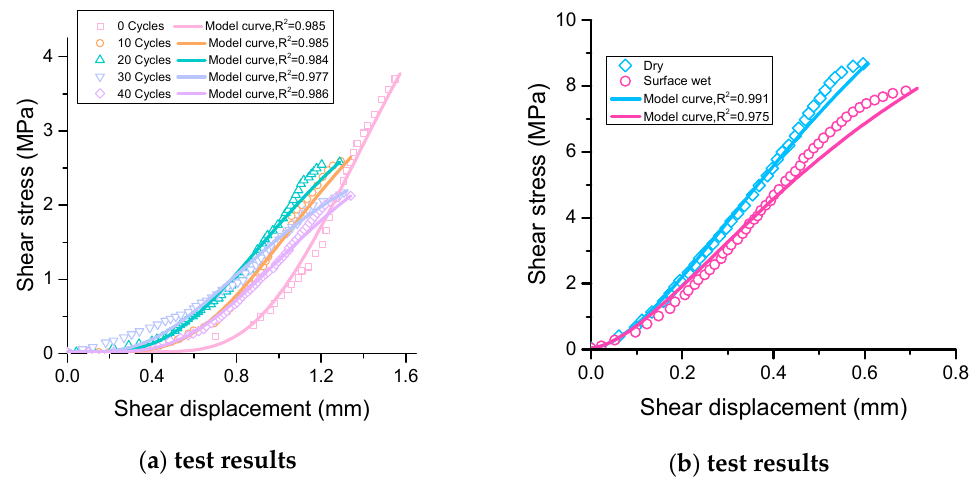
Figure 7. Comparison of test results [73,74] with model curves.The experiment is one of the most fundamental and effective research methods. In Section 3, this paper only focuses on the perfor- mance of the proposed model in describing the shear deformation of rock joints in laboratory ex- periments. Considering that there are many limitations of laboratory experiments, such as difficult field sampling, disturbance to the original state of samples, and defects in laboratory test instru- ments, the results may not be consistent with reality [75]. Therefore, the in situ shear test, which can obtain the mechanical parameters consistent with engineering practice, was employed. Taking the test results [76,77] under in-situ conditions as an example, the perfor- mance of the model in reproducing in situ rock joint behavior is studied. Figure 9 shows the comparison of shear test data with limestone joints collected from the Lanjiberna lime- stone mine (located in Odisha, India) with model curves. Figure 10 shows the comparison of shear test results and model curves for sandstone joint samples collected from the upper reservoir of the Azad pump storage power plant project in western Iran. The correspond- ing fitting curves from the proposed model are well matched with the experimental data in Figures 9 and 10. Obviously, from Figures 9 and 10 (all R 2 values are greater than 0.94), it is not difficult to find that the proposed model can also represent the pre-peak shear deformation behavior of in-situ rock joints to a certain extent. Of course, it is still a com- plex task to estimate the shear behavior of rock joints under in situ conditions due to var- ious influencing factors presented in the field. We will study the performance of this model in reproducing in situ rock joint behavior in geotechnical engineering features such as rock slopes and tunnels in the future.